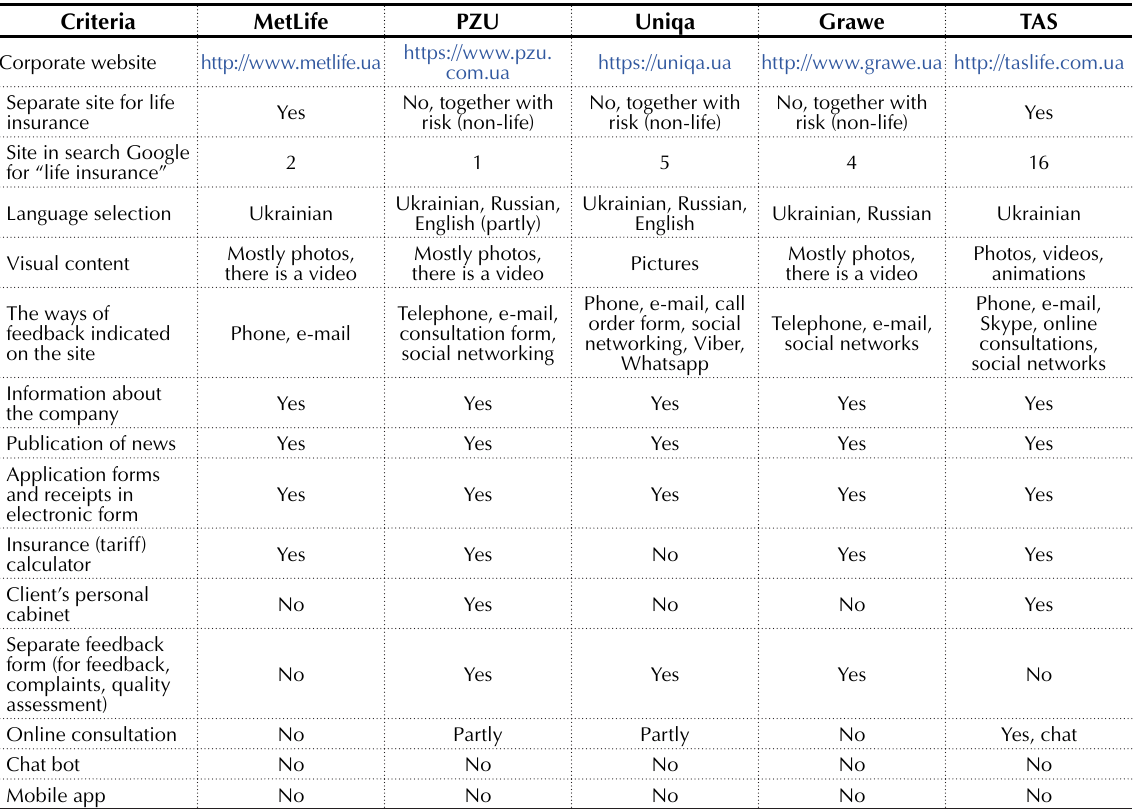
Source: Sites of the companies.